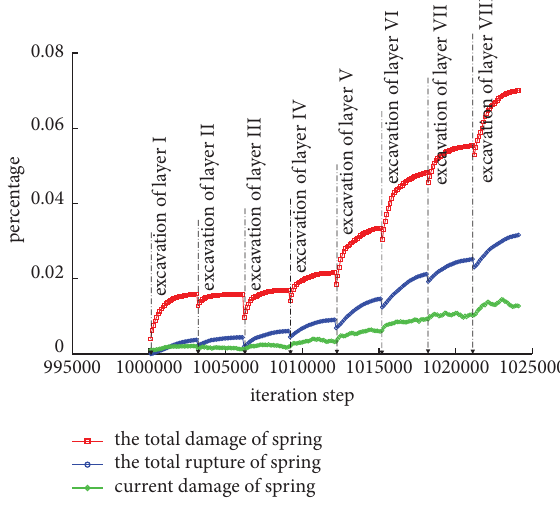
Figure 5: Te statistics of spring